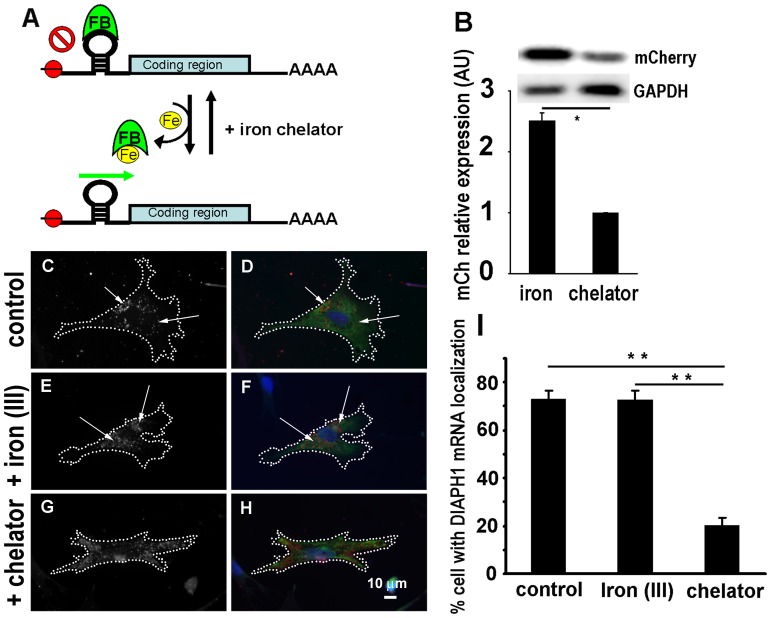
Manipulation of DIAPH1 mRNA localization using an Iron ribo-switch.
A. Schematic diagram of the IRE riboswitch (See Materials and Methods for details). Red balls represent 5′-cap. FB: iron biding protein which also binds to the IRE stem-loop. Green arrow indicates translation permission. B. Western blotting result of mCherry reporter for the effect of IRE in fibroblasts. A construct consisting of IRE-mCherry was transfected into CEF. 3 hr post transfection, ferric ammonium citrate (final 100 µM) or iron chelator desferrioxamine mesylate (final 100 µM) was added into the growth medium. 16 hr after transfection, the cells were collected for Western blotting. Quantitative results of Western blotting (n = 4), * p<0.05. C–H. IRE-mediated control of DIAPH1 mRNA localization. CEF were transfected with a construct consisting of IRE-DIAPH1 and then treated similarly as in B. 16 hr after transfection, the cells were fixed and processed for FISH detection of mRNA localization. C–H. Representative cells. Red: DIAPH1 mRNA signal; Green: HA-tagged DIAPH1 protein signal; Blue: nucleus. C, E & G are gray scale images for better presentation of DIAPH1 mRNA in the cells. Dotted lines show cell border. Arrows indicate localizing DIAPH1 mRNA. I. Quantitative results of DIAPH1 mRNA localization from analysis of 300–500 cells from three independent experiments for each condition. Error bars: sem. ** p<0.01.